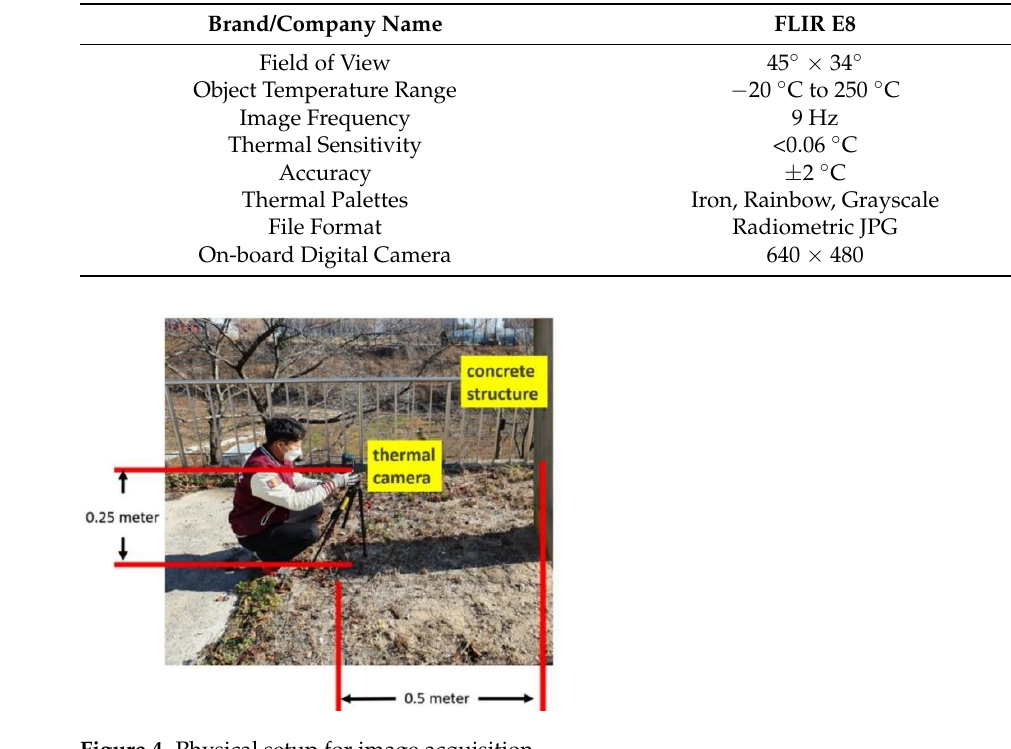
Table 1. Thermal camera technical specifications.